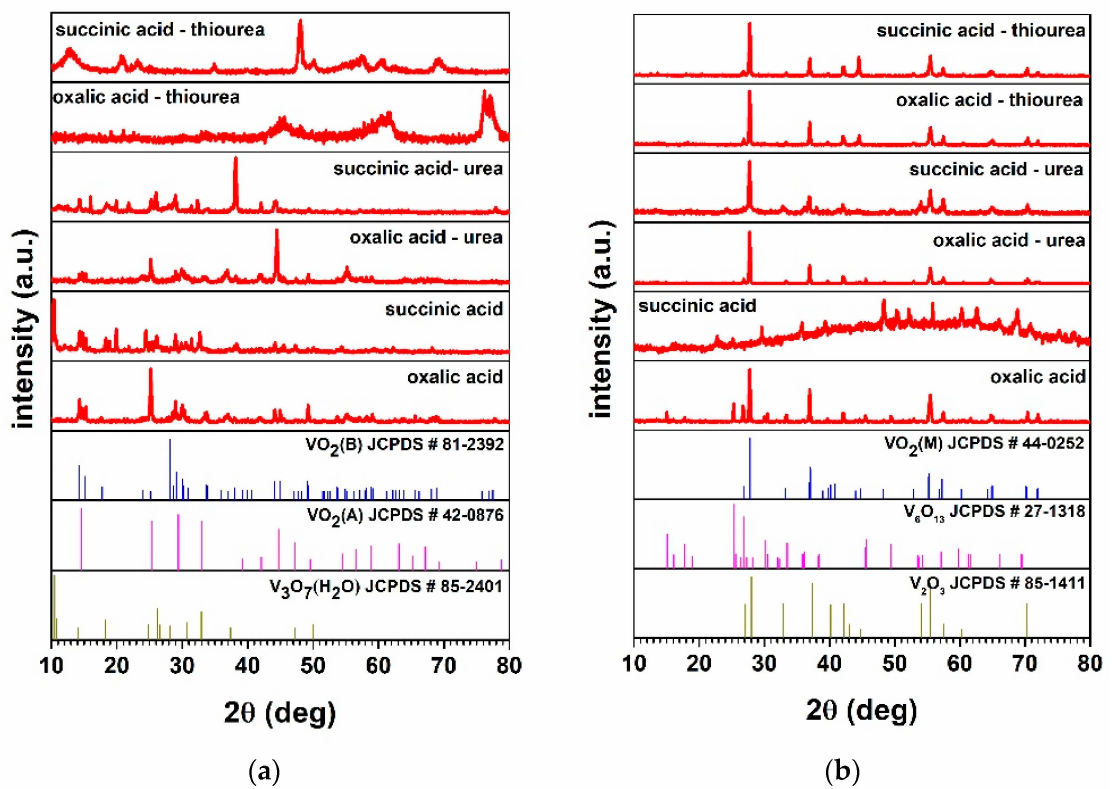
Figure 1. X-ray diffraction patterns of the ‘as obtained’ ( a ) and ‘final’ ( b ) synthesized materials before and after an annealing process. Peak identification was achieved by the following powder diffraction files (PDF): #81-2392 for VO 2 (B), #80-0690 for VO 2 (A), #44-0252 for VO 2 (M), and #27-1318 for V 6 O 13